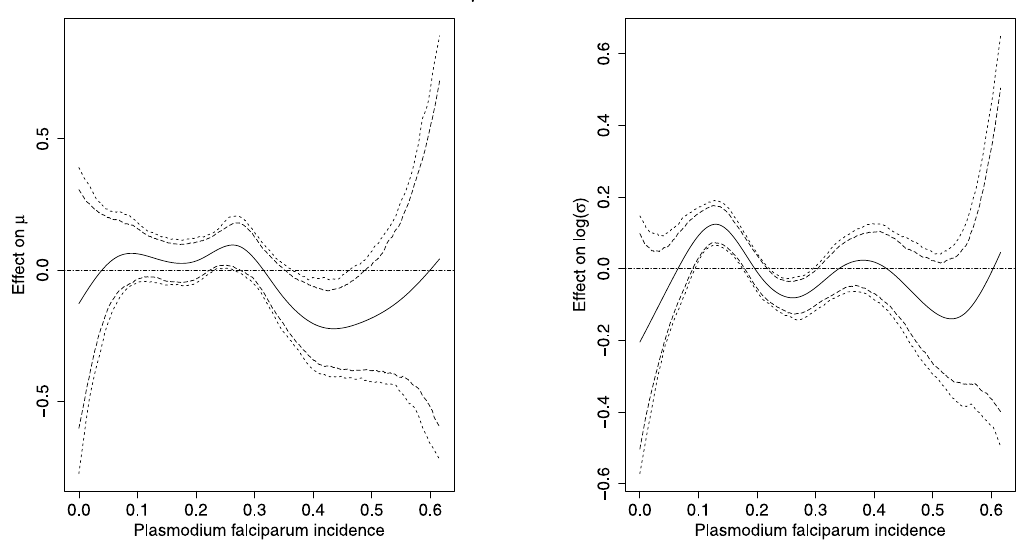
Fig 5. Non-linear effects of the malaria incidence. The Figure depicts the mean effects on the mean μ (left), and the standard deviation σ (right) together with 80 per cent and 95 per cent simultaneous credible intervals for the malaria incidence. Source : Demographic and Health Surveys (data); calculation by authors.